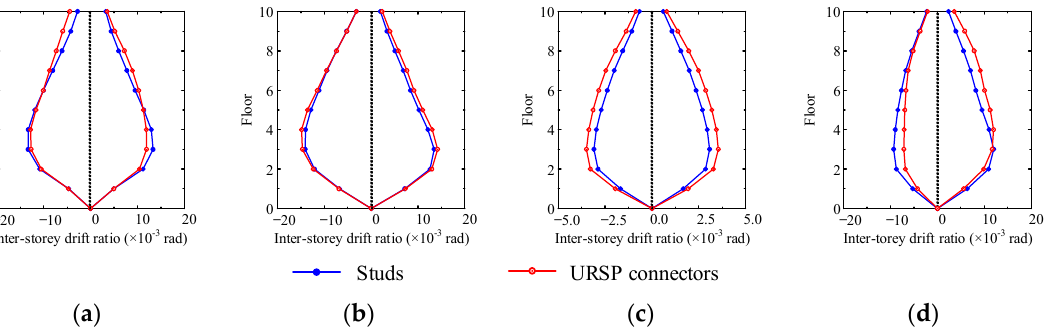
Figure 10. Inter-story drift ratio when the maximum roof displacement occurred: ( a ) case XL1; ( b ) case YL1; ( c ) case YS1; ( d ) case XL2.